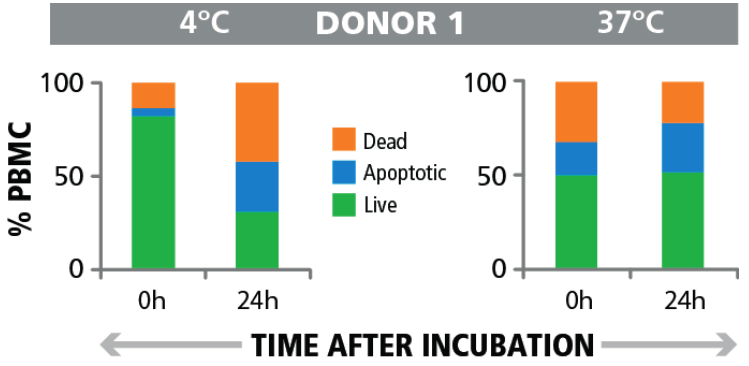
Figure 6. Frequency of apoptotic cells pre- and post PBMC testing in the ELISPOT